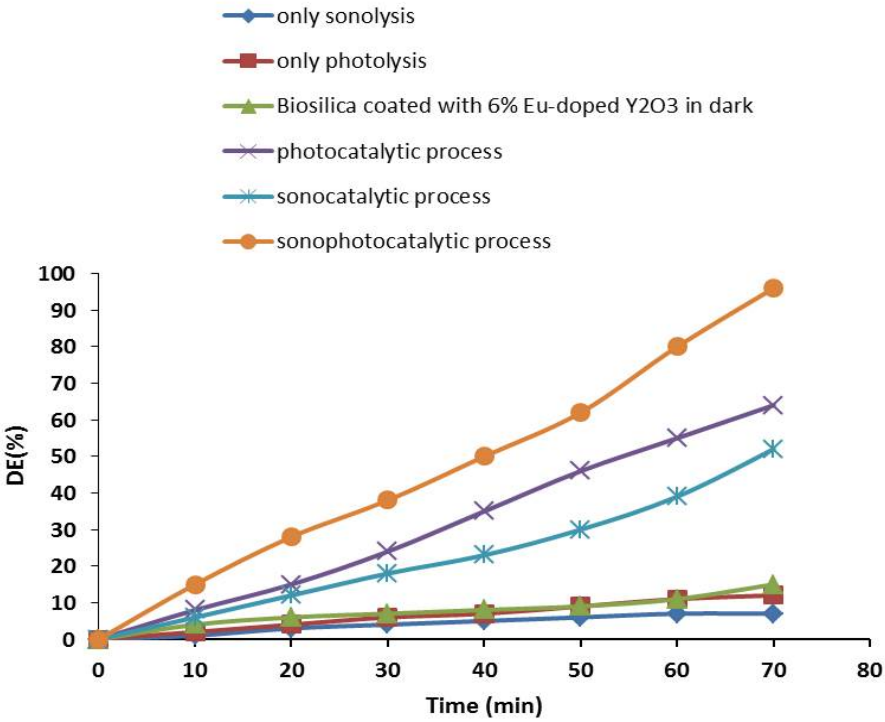
Figure 9. Comparison of different catalytic processes in decolorization of reactive blue 19, [Dye] = 20 mg/L, [Catalyst] = 1.25 g/L, pH = 6.